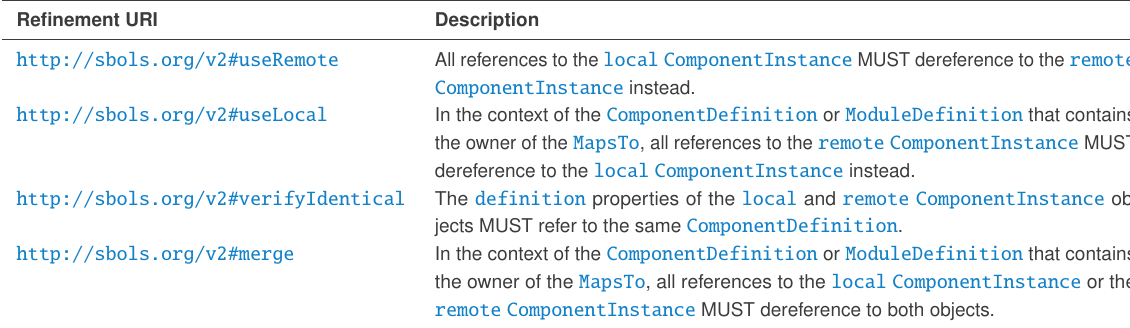
Table 5: REQUIRED URI s for the refinement